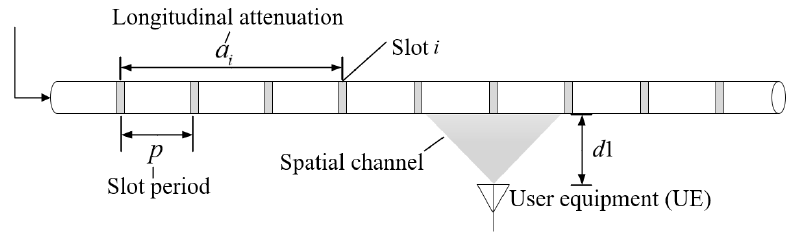
Figure 7. Channel transmission in leaky cable.